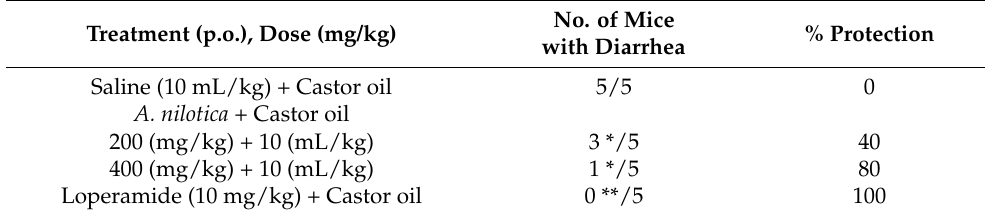
Table 2. Antidiarrheal activity of the methanolic extract of A. nilotica on castor oil (10 mL/kg)-induced diarrhea in mice.